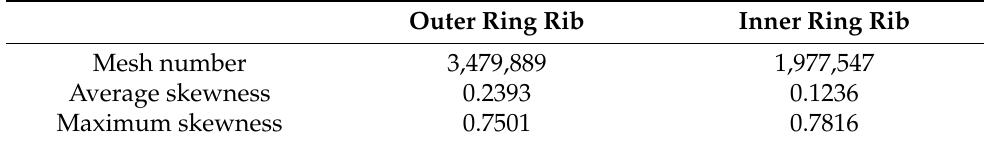
Figure 9. Results of grid independence verification. ( a ) Outer ring rib structure; ( b ) Inner ring rib structure. Table 2. Mesh quality parameters.